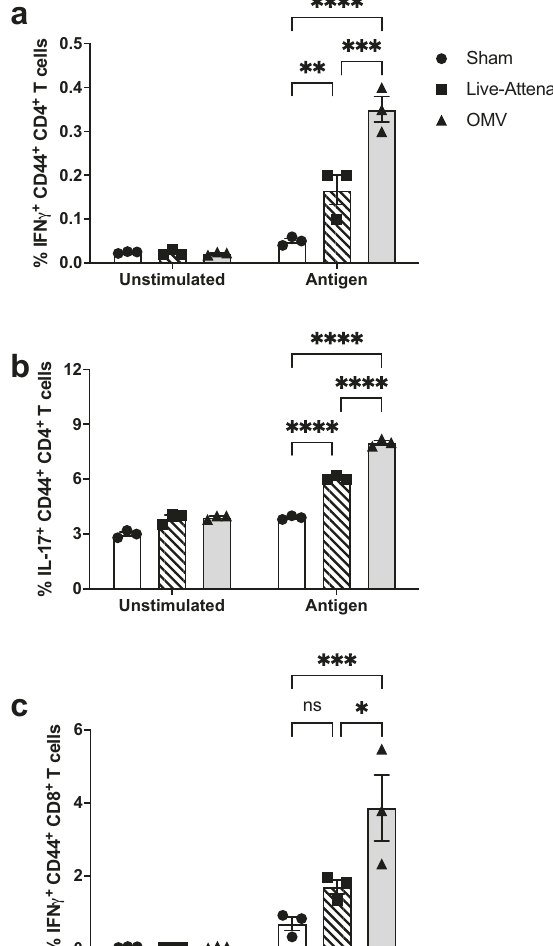
CD8 T-cell responses. a – b Antigen-speci fi c CD44 + CD4 + T cell and c CD8 + T-cell responses were measured in the spleens of mice ( n = 3 per group) immunized with M9 OMV, live-attenuated vaccine, or sham (saline). Splenocytes were restimulated with a-CD28 and heat- inactivated Bp82 grown in M9 (antigen). PMA/ionomycin-treated and unstimulated groups were used as controls. Cytokine-producing T cells were assessed by intracellular cytokine staining and fl ow cytometry. * p < 0.05, ** p < 0.01, *** p < 0.001, **** p < 0.0001. ns = not signi fi cant. Statistical analysis was performed using two-way ANOVA with Tukey ’ s multiple comparisons test. Results are representative of two independent